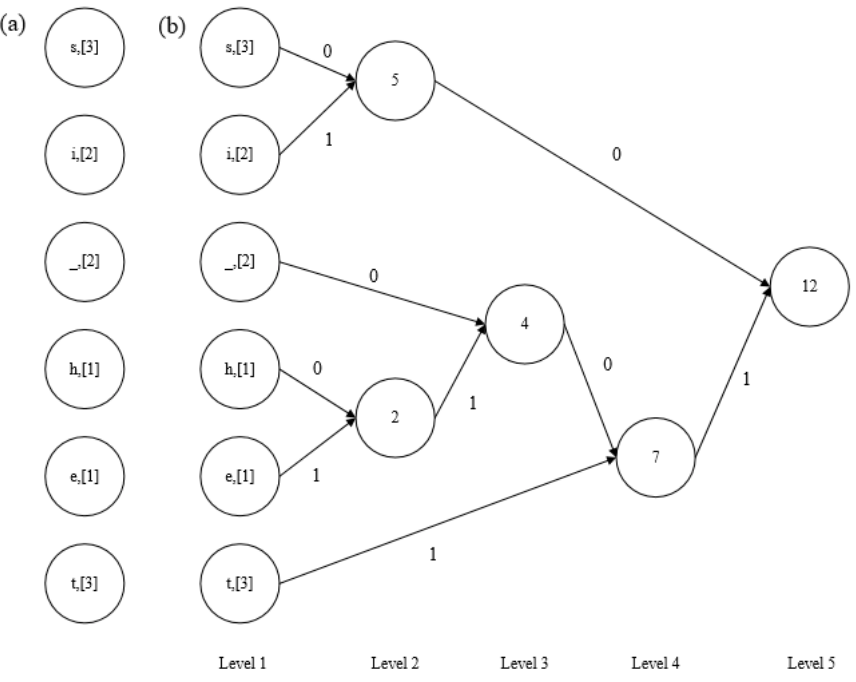
Figure 3. Huffman tree of ‘this_is_test’ text. ( a ) Frequency of letters; ( b ) Huffman tree.